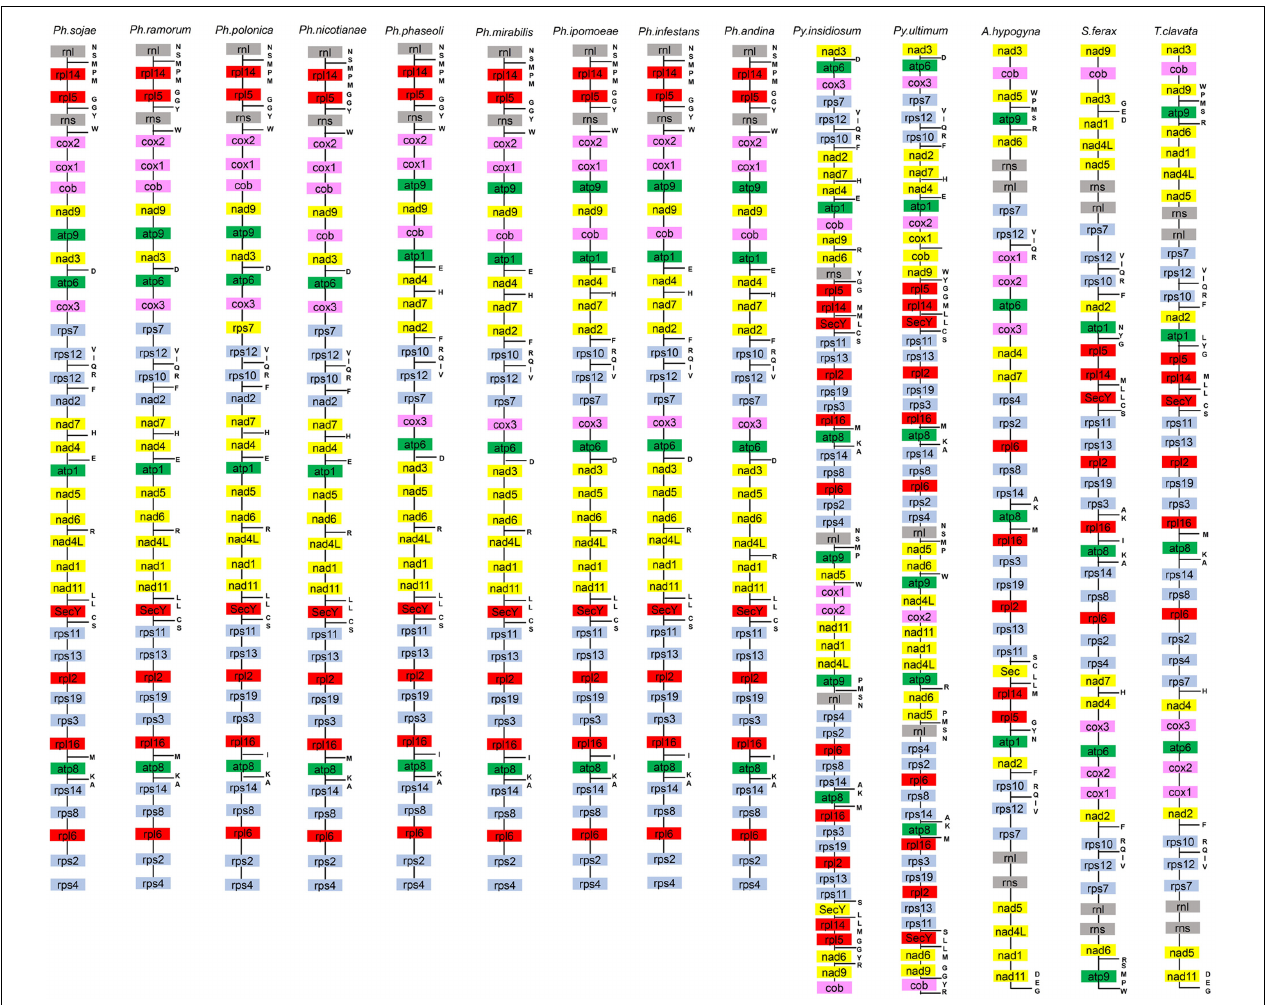
FIGURE 3 | Mitochondrial gene orders of 14 species from the Oomycetes. Gene orders and contents of 14 species are listed from top to bottom. Genes in different colors represent different functions. tRNA which can comprise amino acids are listed on the right of gene